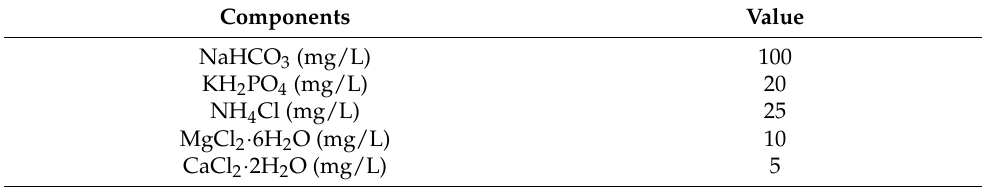
Table 2. Inorganic composition of the synthetic wastewater used in this study.